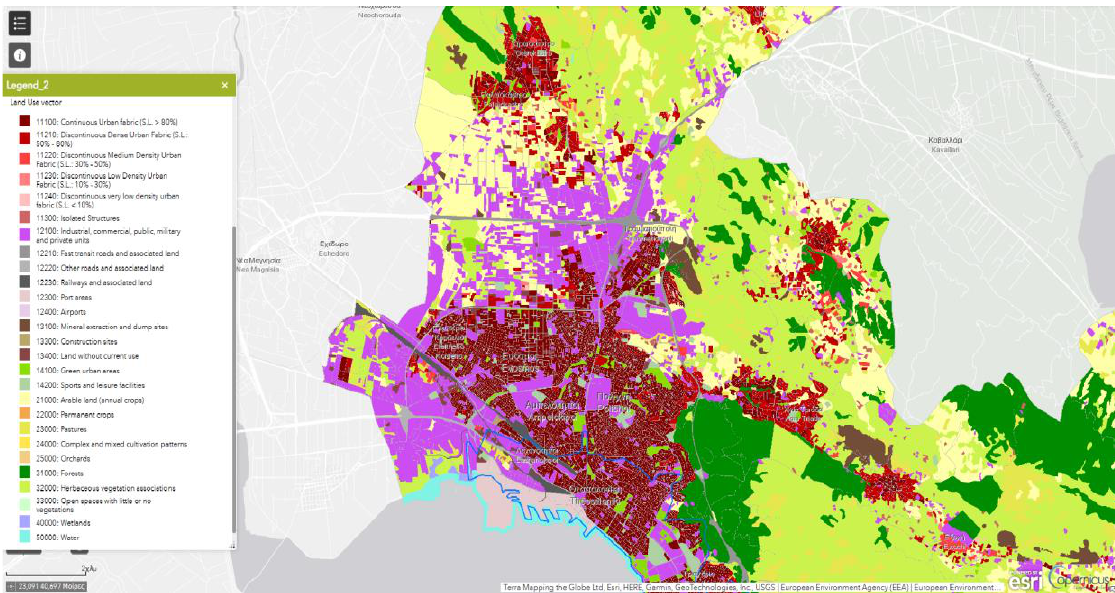
Figure 3. Land-use regimes of Thessaloniki (via the Copernicus Urban Atlas). Original land uses were combined in six classes (see text).